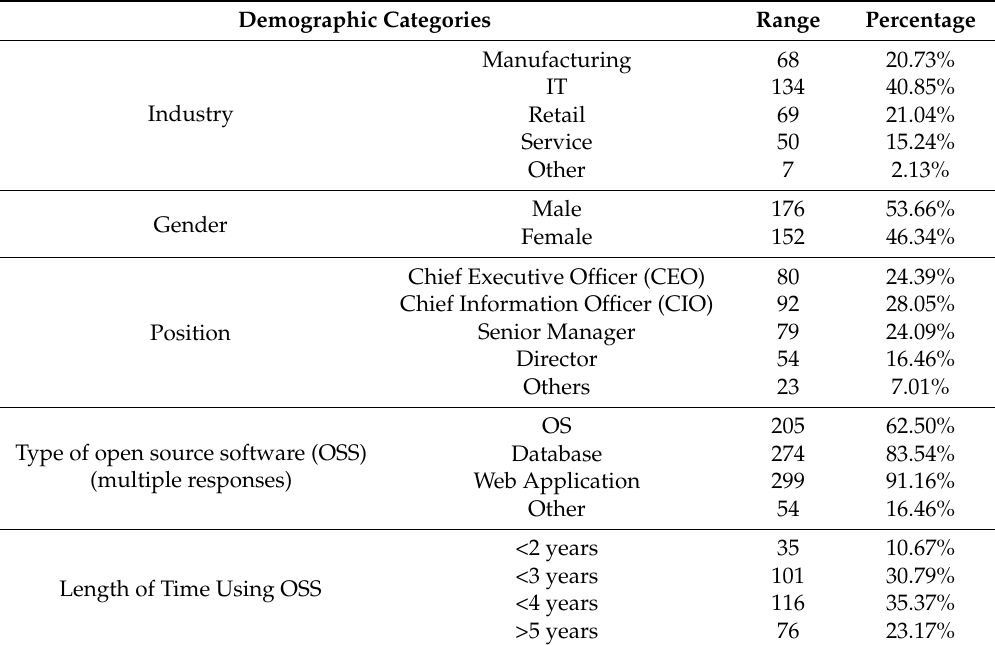
Table 1. Breakdown of the study participants ( n = 328).